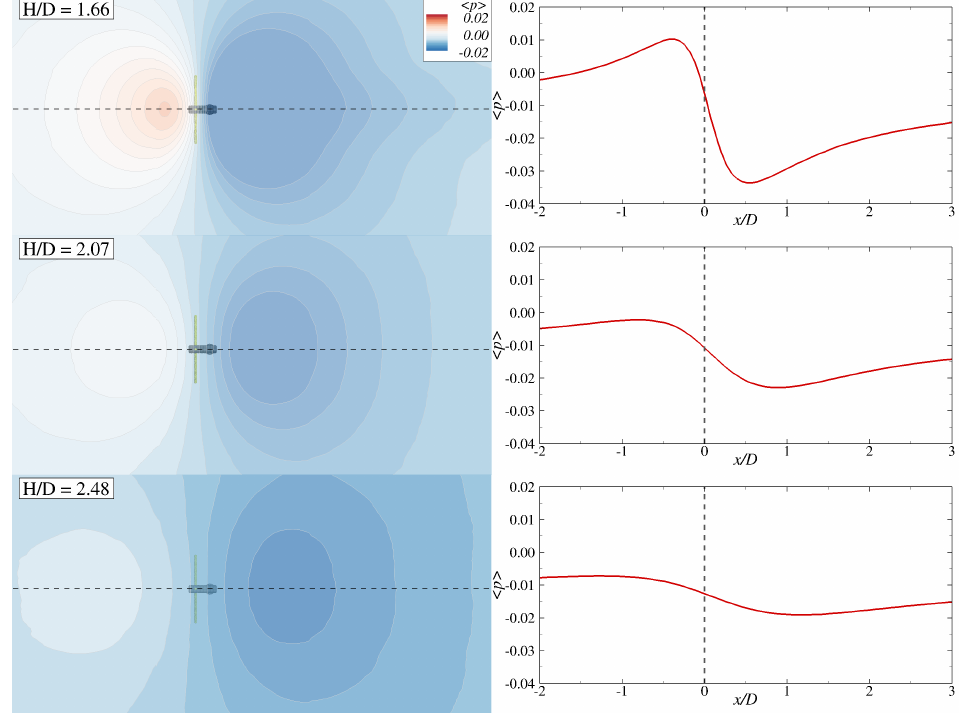
Fig. 5. Distribution of mean relative pressure at the top rigid-lid over the xy horizontal plane for the three submergence cases H/D = 1.66, 2.07 and 2.48. The distribution of relative pressure along the line at y/D = 0 are provided on the right hand